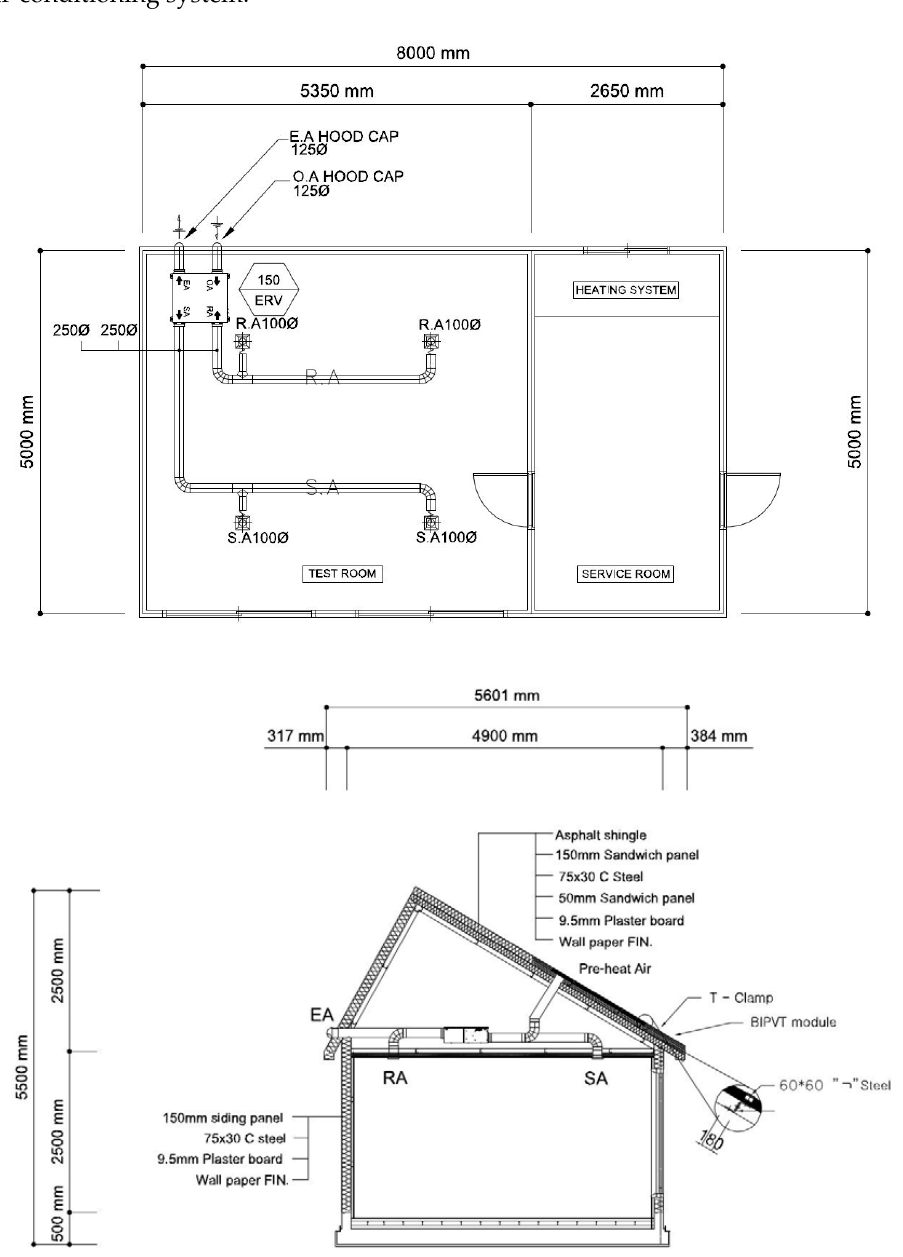
Figure 4. Sectional and plan view of the experimental house.